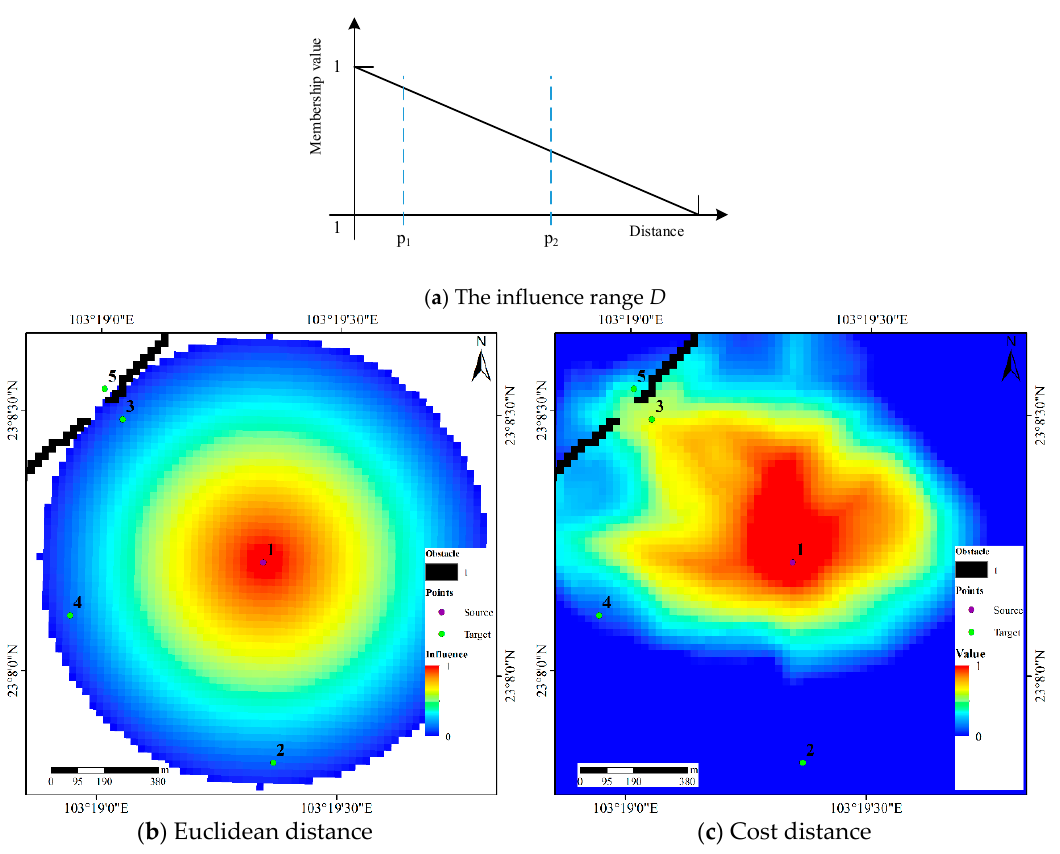
Figure 9. The influence area of source point 1 induced by the Euclidean distance and the cost distance, respectively.